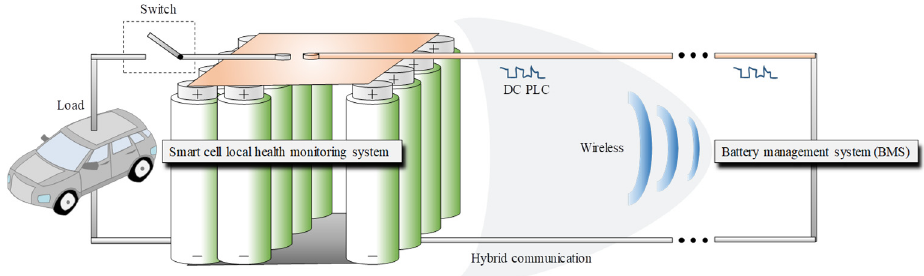
Figure 1. Battery monitoring system (BMS) research objectives.